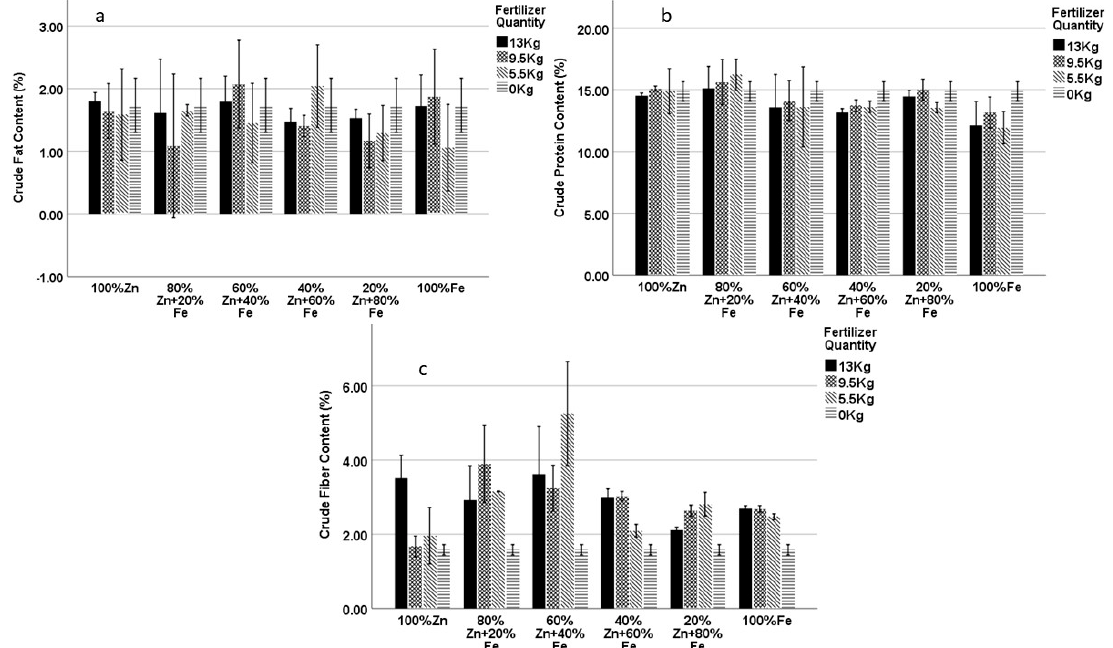
Figure 3. Crude fat (a), crude protein (b), and crude fiber (c) content in wheat grains as affected by foliar application of combined Zn and Fe fertilizers. Plotted values are means of two cropping seasons. Vertical bars represent the 95% confidence interval.